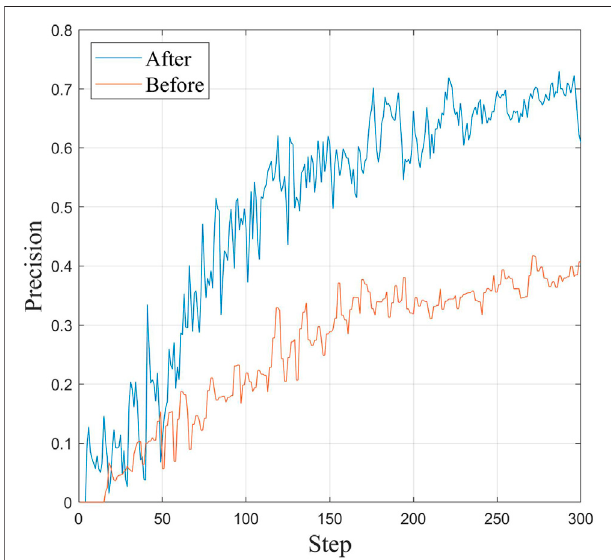
FIGURE10| TheimprovedYOLOalgorithmandthechangeinaccuracy with training times before improvement.